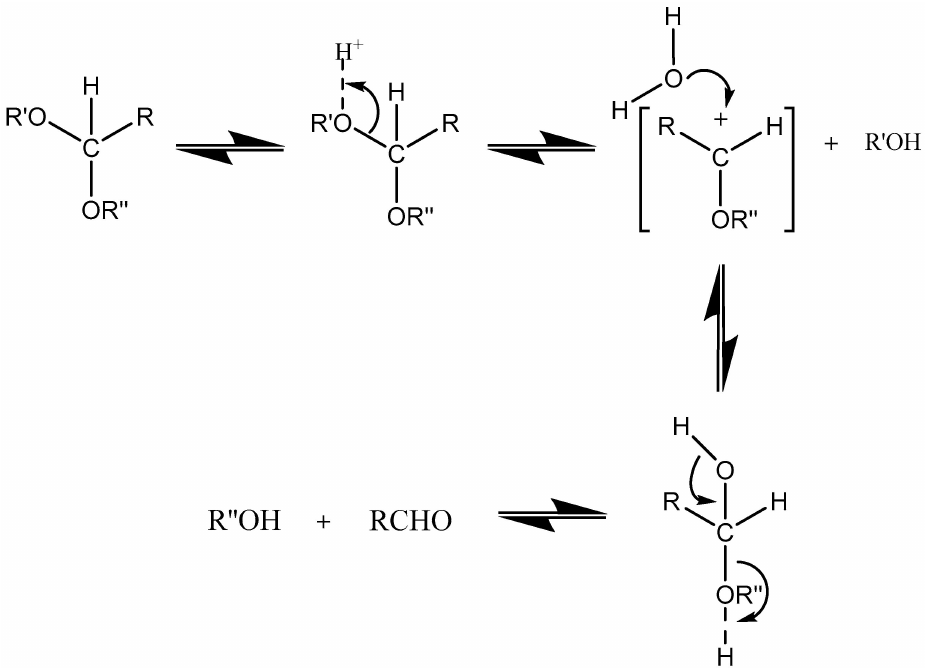
Figure 7. ( a ) Conformational switch of TACH in a low pH endosomal environment. ( b ) Release of drug contents from the Fliposome after the conformational switch of the TACH lipid on the Fliposome